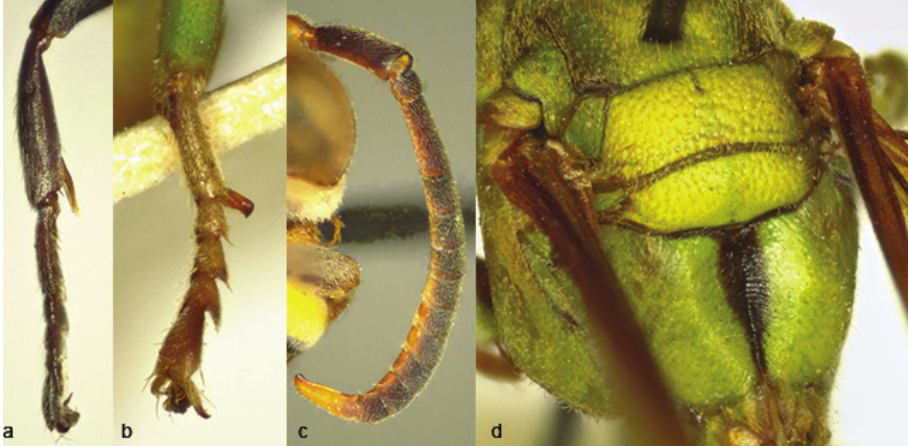
Figure 4. Comparative morphology of a R. amabala sp. nov., male, tarsal I spur b R. saussurei Kojima, male, tarsal I spur c R. minor (de Saussure), male, antenna d R. saussurei Kojima, propodeal excavation, oblique posterior